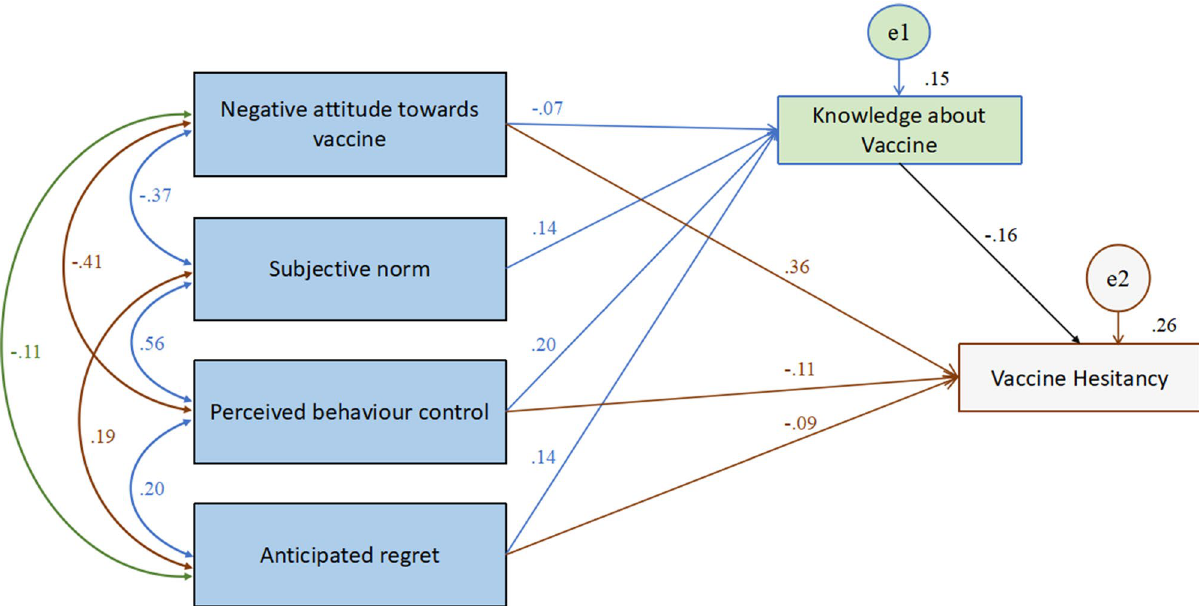
Figure 2. The mediating effects of knowledge about vaccines on the relationship between TPB constructs and vaccine